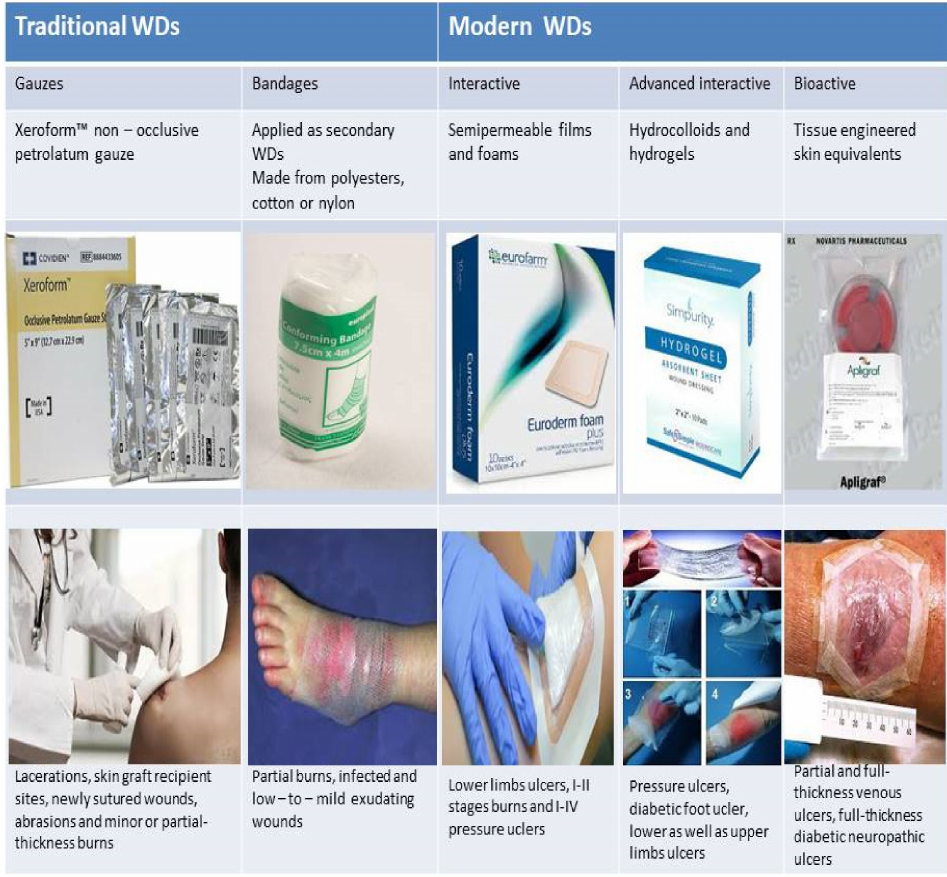
Figure 2. Briefly description of WDs types with